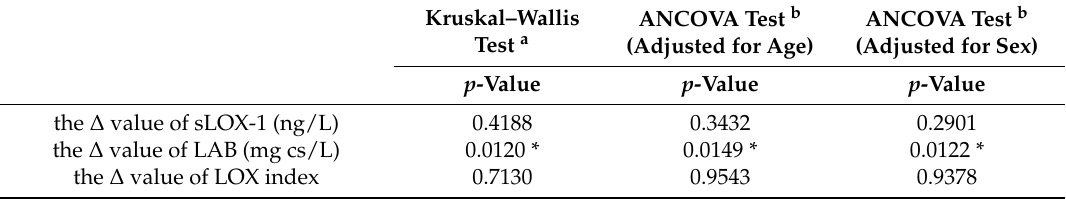
Table 3. The age- and sex-adjusted analyses in the ∆ value of sLOX-1, LAB and LOX index at 12 weeks between three groups.